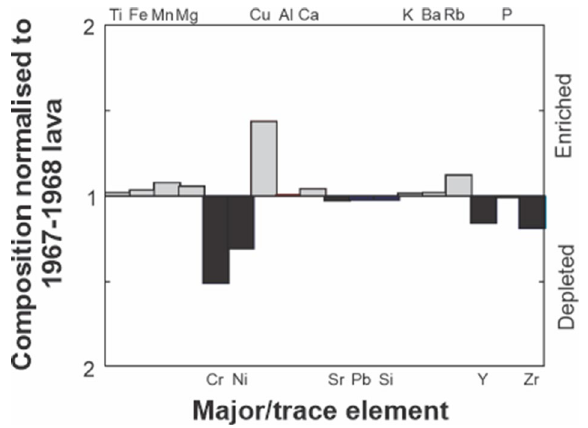
Figure 7. Enrichment-depletion diagram showing the variation in major and trace elements for eruptions at Late’iki. The composition of the 2019 eruption is normalised to the composition of the 1967–1968 eruption 26